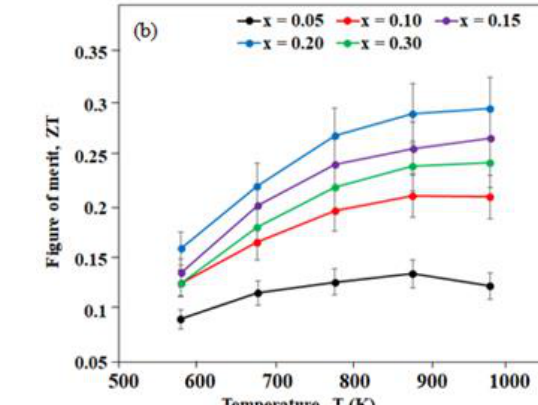
Figure 7. Temperature dependence of ( a ) electrical conductivity, σ ; ( b ) Seebeck coefficient, |S|; and ( c ) power factor, PF, for VSTO-H ceramics. ( c ) power factor, PF, for VSTO-H ceramics.